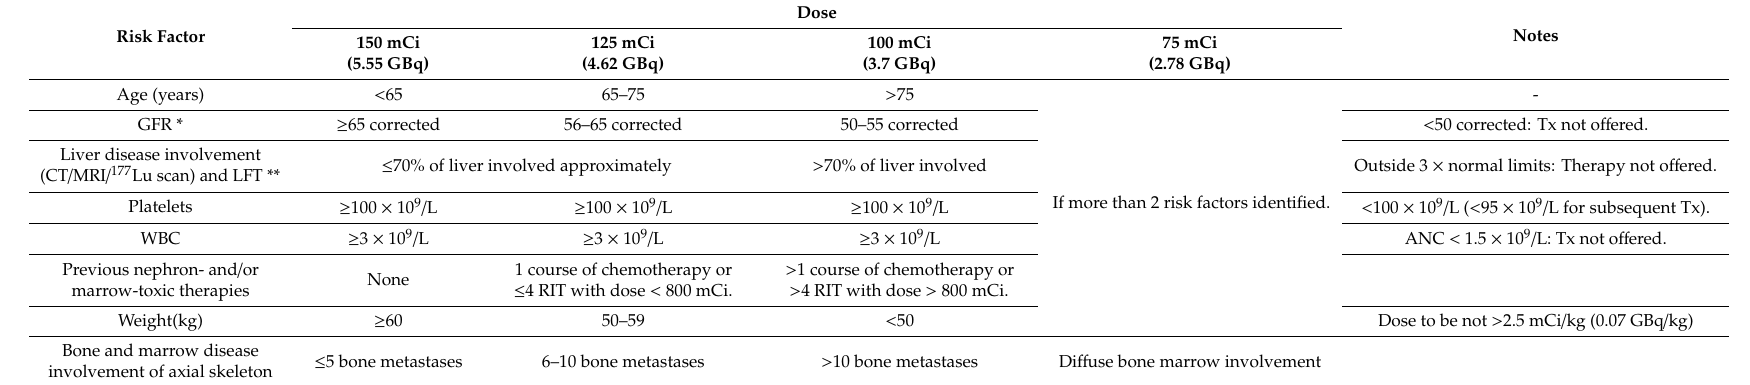
Table 1. Dose regimen determination and modification for treatment. * Based on Cockcroft-Gault formula of creatinine